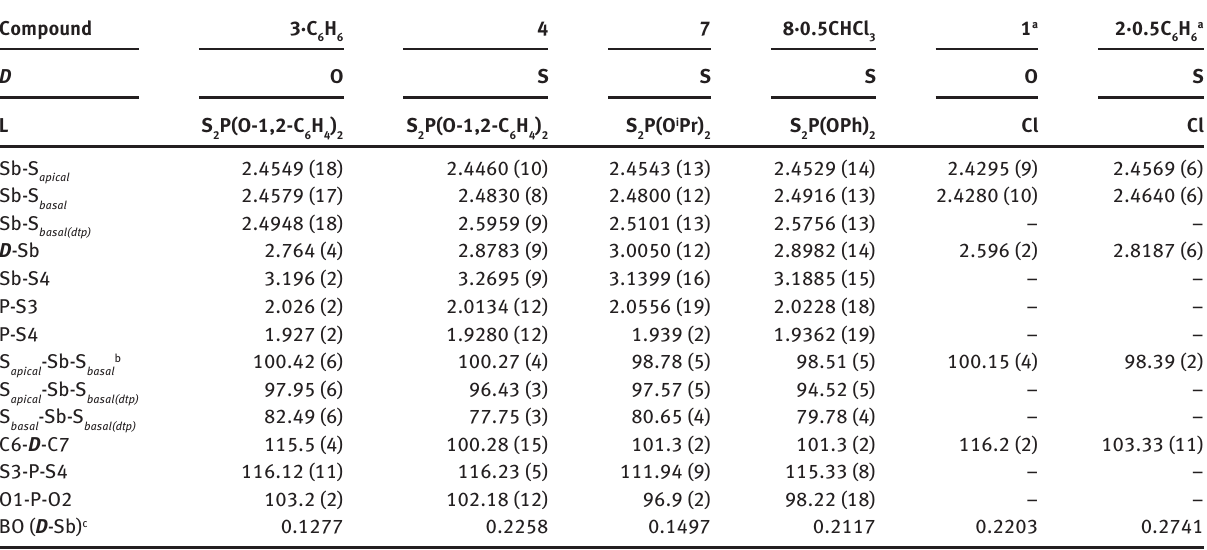
Table 1 Selected bond lengths ( Å ) and angles ( o ) for [ { D (C the sake of comparison. Values in parentheses are the estimated standard deviations.